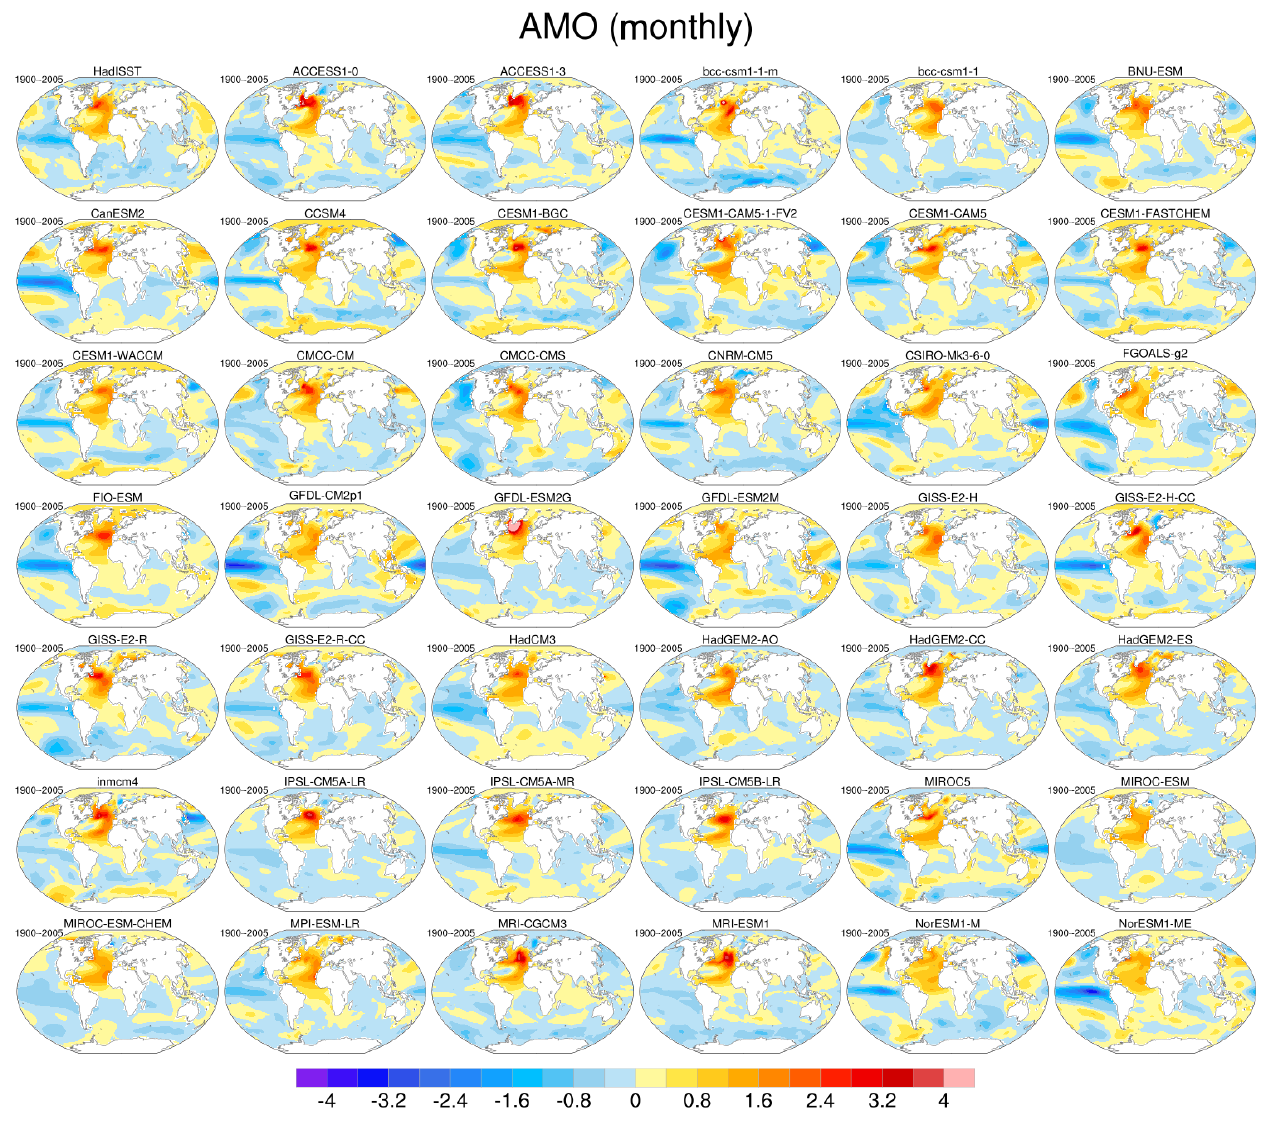
Figure 14. Representation of the AMO in 41 CMIP5 models (individual panels labelled by model name) and observations (first row, upper left panel) for the historical period (1900–2005 for models and 1920–2017 for observations). These patterns are based regressing monthly SST anomalies (denoted SSTA ∗ ) at each grid box onto the time series of the AMO SSTA ∗ Index (defined as SSTA ∗ averaged over the North Atlantic 0–60 ◦ N, 80–0 ◦ W), where the asterisk denotes that the global (60 ◦ N–60 ◦ S) mean SSTA has been subtracted from SSTA at each grid box following Trenberth and Shea (2006). Figure produced with recipe_CVDP.yml ; see details in Sect.